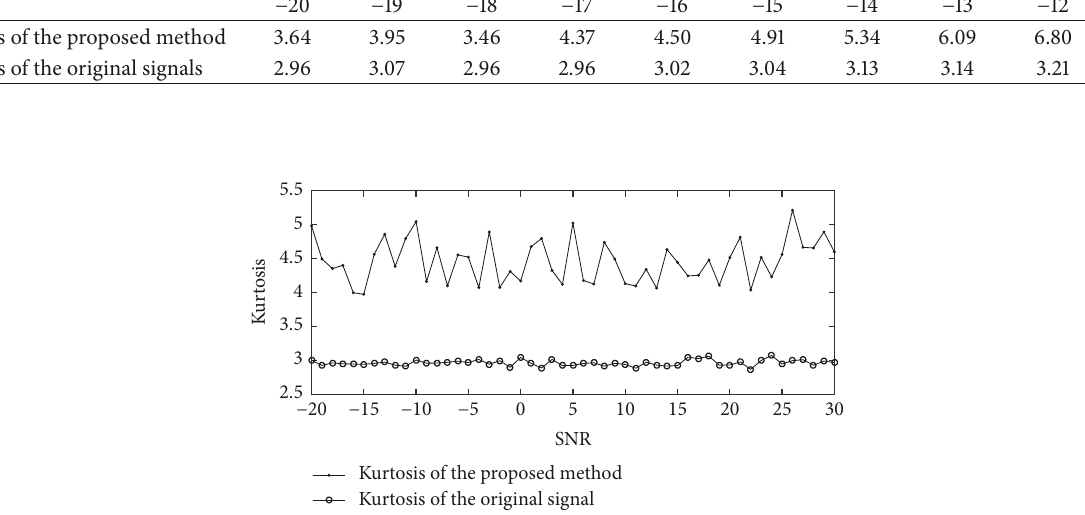
Figure 11: The kurtosis values of the proposed method and the original signal for the simulated signals with different